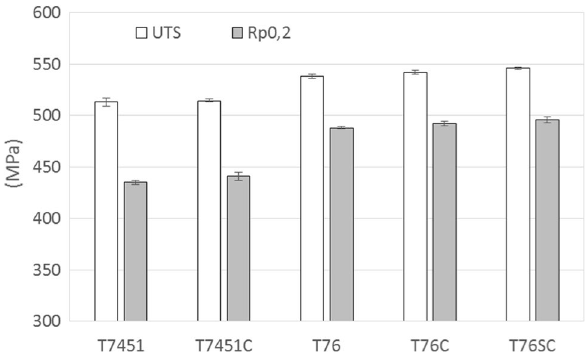
Fig. 6 Ultimate tensile strength (UTS) and yield strength (Rp0.2) in the investi- gated conditions, LT direction